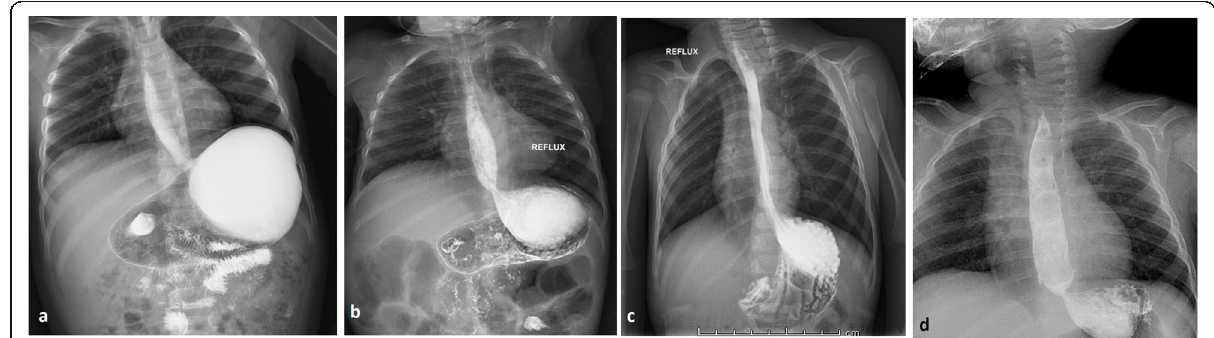
Fig. 5 Different patterns of idiopathic gastroesophageal reflux. a Reflux exceeding the middle third of the esophagus with no luminal dilatation. b Reflux reaching up to the level of mid-esophagus with luminal dilatation. Larger amount of reflux reaching up to the level of upper esophagus without ( c ) and with luminal dilatation ( d